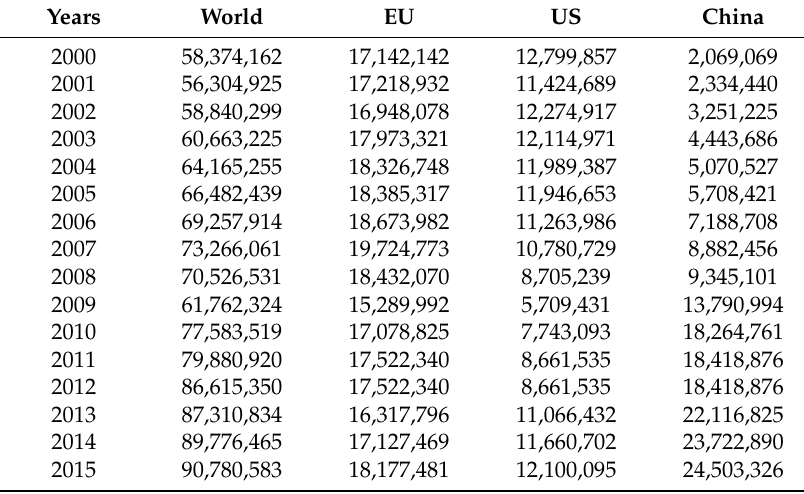
Table 1. Evolution of car production (number of cars produced).